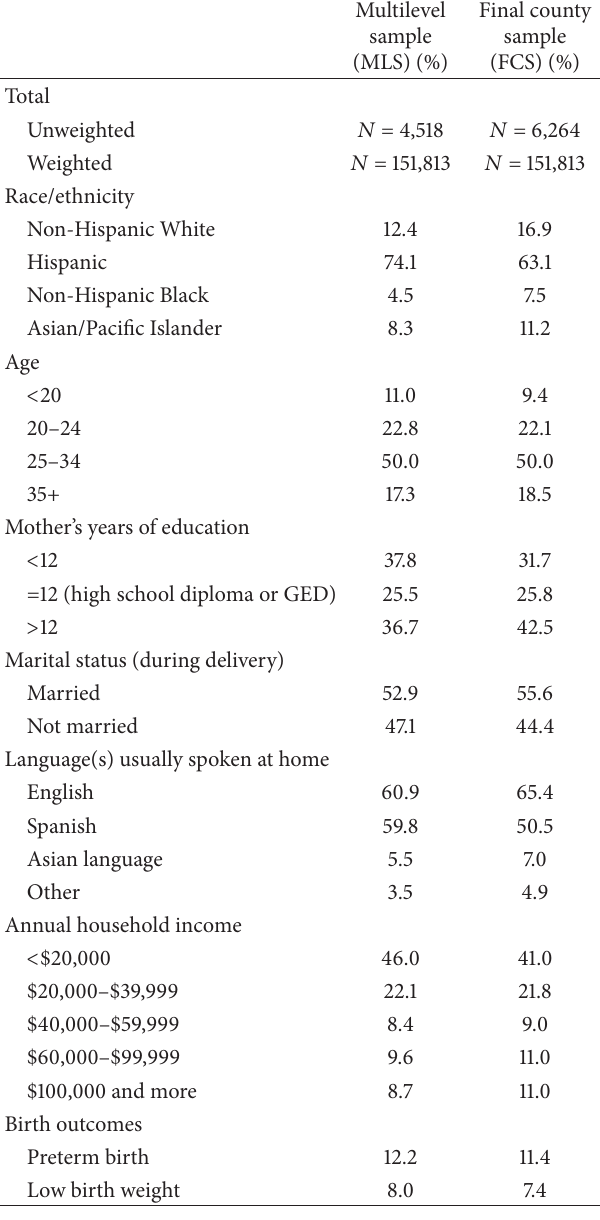
Table 3: Weighted percentage distribution of selected maternal characteristics and birth outcomes in 2007 LAMB